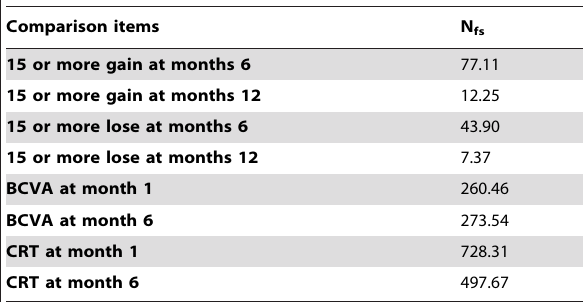
Table S1 Factors implicated in the pathogenesis of central retinal vein occlusion.